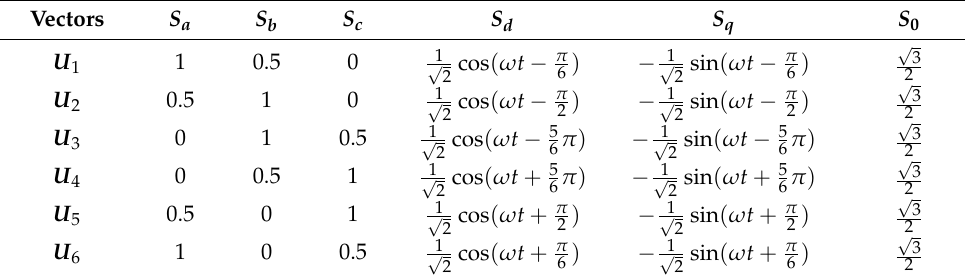
Figure 2. The synthesized voltage vectors. Table 2. The switching functions of the synthesized voltage vectors.